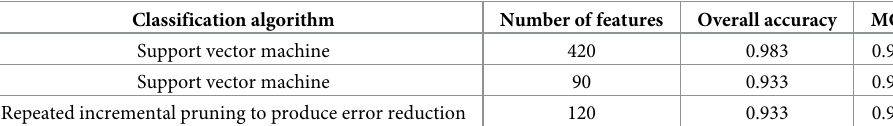
Table 1. Performance of some key